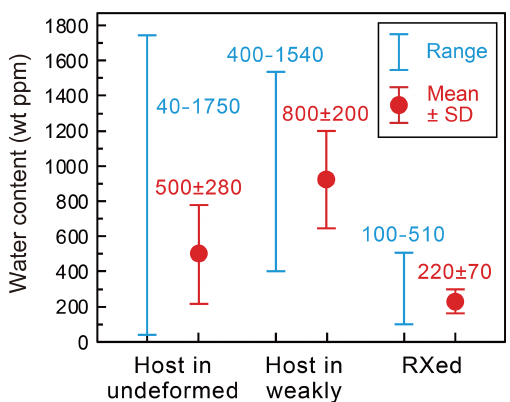
Figure 10. Summary of water content variations in quartz. “Host” represents host quartz grains as grain interiors in the almost- undeformed and weakly deformed samples. These two samples are referred to as undeformed and weakly in the figure, respectively. “RXed” represents regions of recrystallized quartz grains, including both grain interiors and grain boundaries in the weakly deformed and strongly deformed samples. Ranges from the lowest to high- est contents in blue and means with standard deviations (SD) in red are shown. The difference between the almost-undeformed and weakly deformed samples in terms of water contents in host grains may be because of the areas to be measured. In addition, the water distributions in host grains in the weakly deformed sample corre- spond to the shapes of host grains (Figs. 7 and 8), but those in the almost-undeformed sample do not (Fig. 6). Therefore, there may be a redistribution of water in host grains by plastic deformation, as supported by the photomicrographs, which show fewer visible fluid inclusions in the latter sample (Fig.